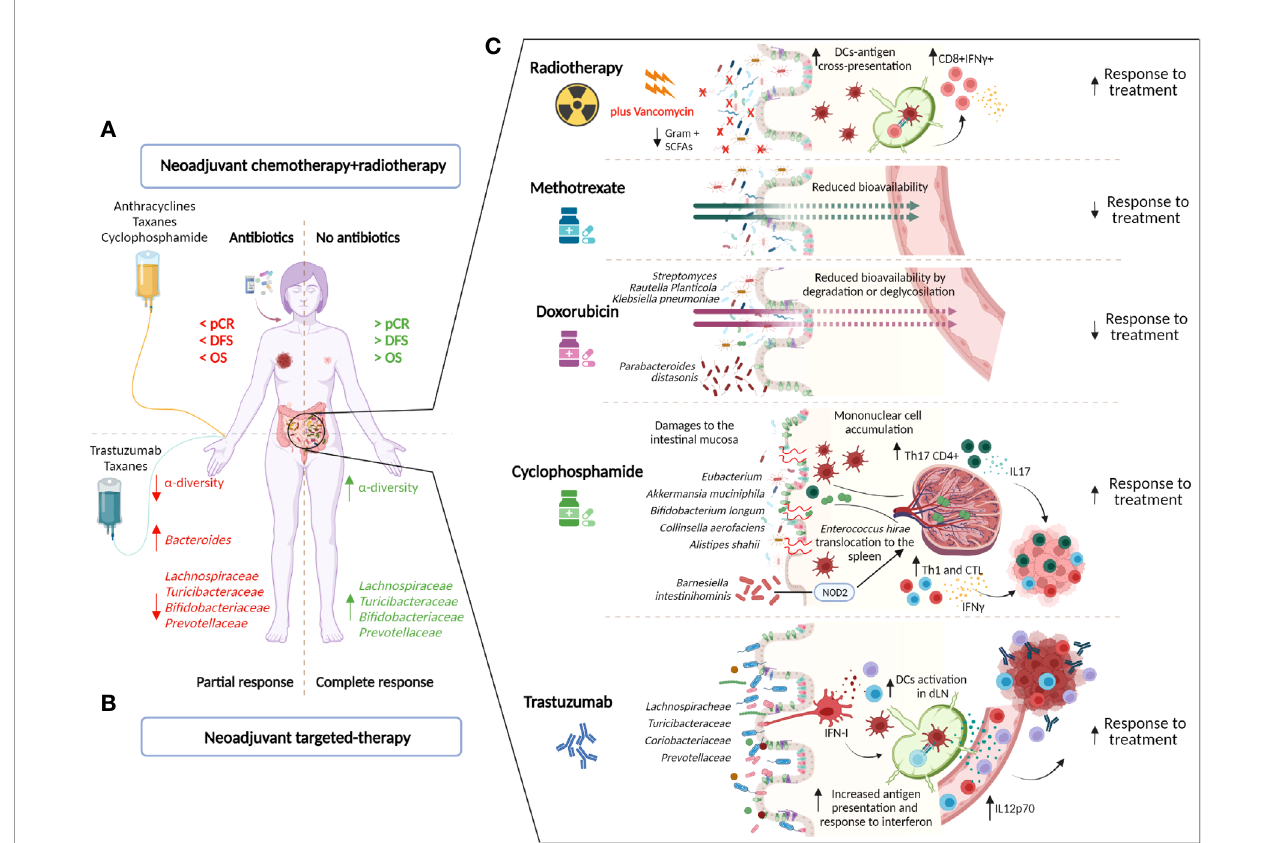
FIGURE 1 | Impact of the gut microbiota on the treatment of HER2+ BC patients. Current HER2+ BC treatments comprise radiotherapy (RT), chemotherapy (anthracyclines, taxanes, cyclophosphamide (CTX), methotrexate, and 5- fl uorouracil), and anti-HER2 agents (trastuzumab). The gut microbiota can affect treatment ef fi cacy by directly in fl uencing drug metabolism or by shaping the host ’ s immune response to the treatment. In patients, the use of antibiotics near the neoadjuvant therapy negatively affects the response to treatment and is associated with lower disease-free (DFS) and overall (OS) survival (72). (A) . Moreover, an intestinal microbiota that is low in bacteria that belong to the taxonomic families Lachnospiraceae , Prevotellaceae , Actinobacteria ( Bi fi dobacteriaceae ), and Turicibacteriaceae but enriched in Bacteroides is associated with the response to trastuzumab-containing neoadjuvant chemotherapy (73). (B) . Several mechanisms have been proposed to explain the in fl uence of gut microbes on anticancer treatment. (C) . Radiotherapy induces DNA damage in cancerous cells and causes immunogenic cell death, eliciting adaptive antitumor immunity, due to tumor antigen cross presentation by dendritic cells (DCs) to cytotoxic CD8+ T cells. The depletion of vancomycin-sensitive gram+ bacteria enhances DC antigen presentation, improving RT ef fi cacy (74). Methotrexate and doxorubicin can be converted into downstream metabolites, reducing their bioavailability (75, 76). In particular, Streptomyces and Raoultella >planticola inactivate doxorubicin by deglycosylation, whereas Klebsiella pneumoniae reduces its bioavailability by degradation (76). Moreover, gut colonization with Parabacteroides distasonis is associated with compromised anticancer ef fi cacy (77). CTX damages the gut mucosa, rendering the gut leaky and allowing bacteria to translocate to secondary lymphoid